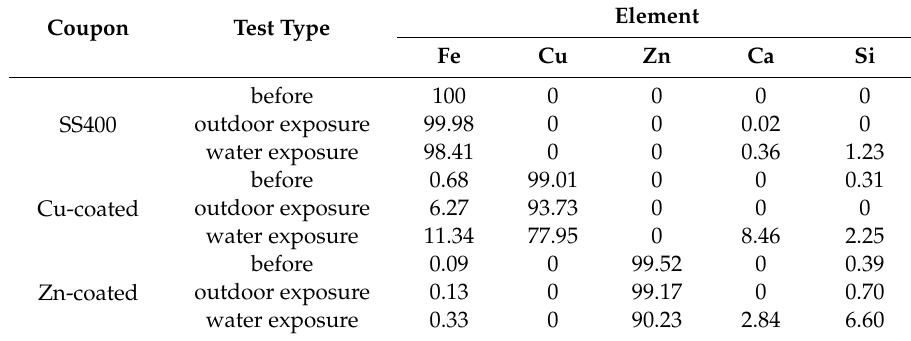
Table 5. Main components of the surface of each coupon before and after the exposure tests (mass %).